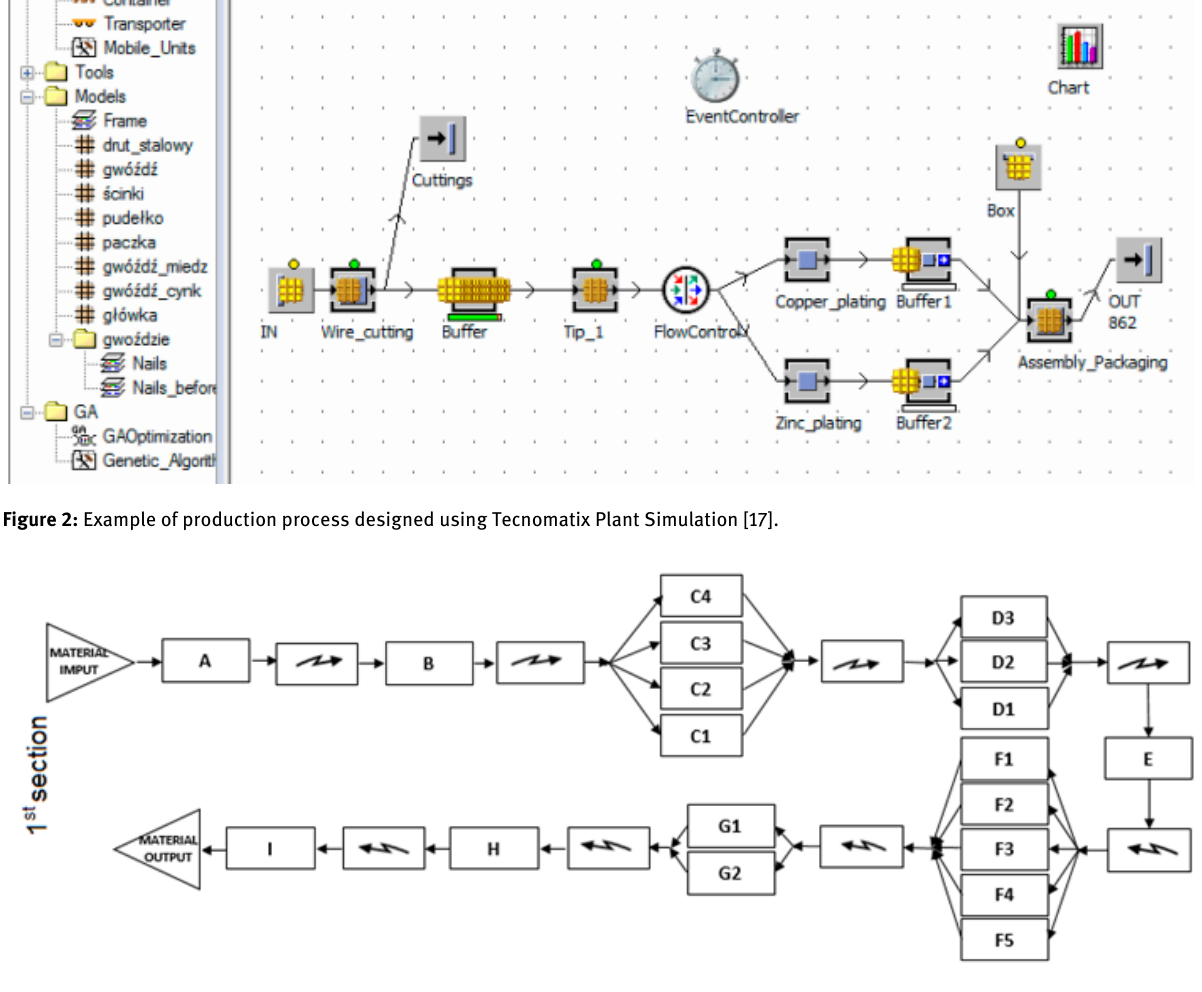
Figure 3: The formalised scheme of the production process.